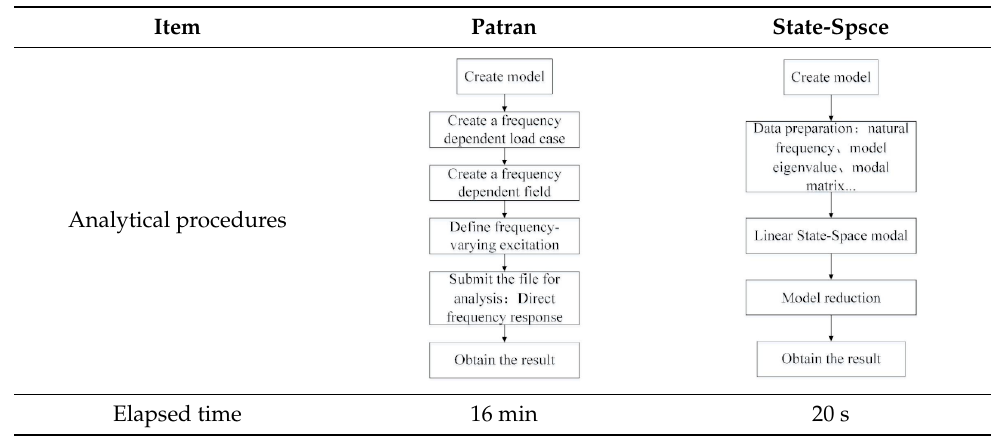
Table 1. Comparison of calculation efficiency between FEA and state space.